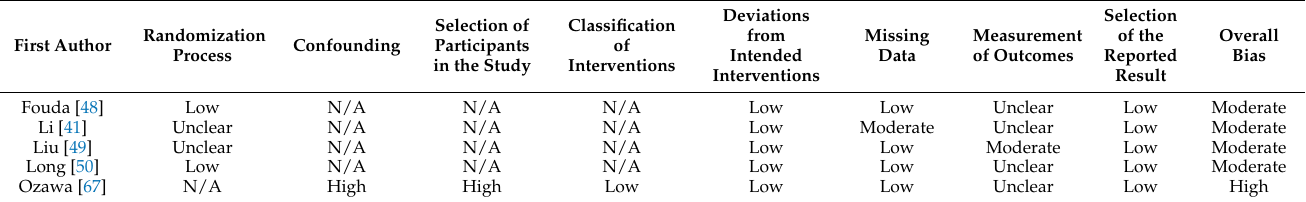
Table 3. Risk of bias